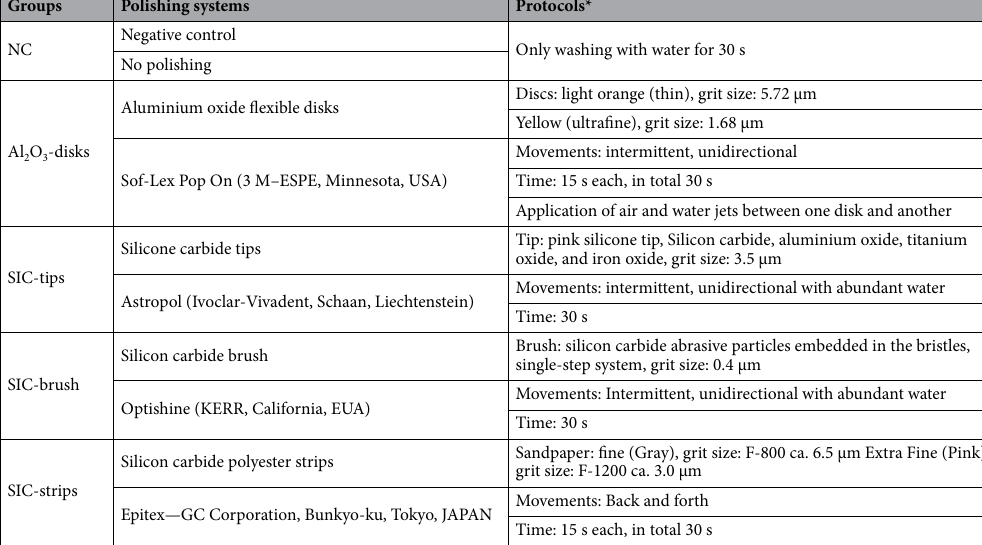
Table 1. Detailed description of polishing groups, trademarks and adopted application protocols. Grit sizes are provided for all instruments in µm. *For all protocols, the discs, tips, brushes, or strips were changed after the polishing of each 3rd